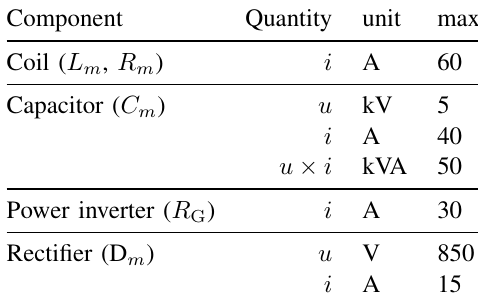
TABLE II C ONSTRAINTS ON RMS VALUES OF THE CURRENTS AND VOLTAGES , WHICH ARE ENFORCED FOR THE COMPONENTS LISTED WITHIN THE PARENTHESES FOR m = 1 ,..., 4